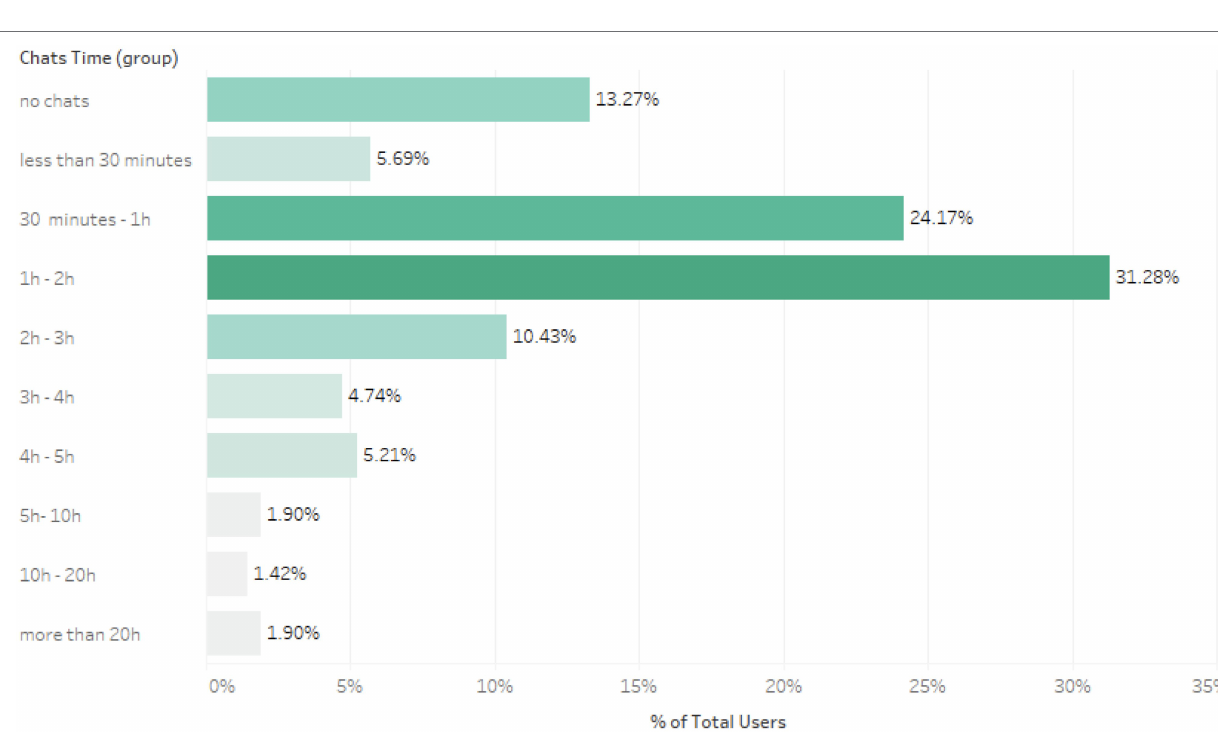
FIGURE 2 | The time period each individual spent chatting to a